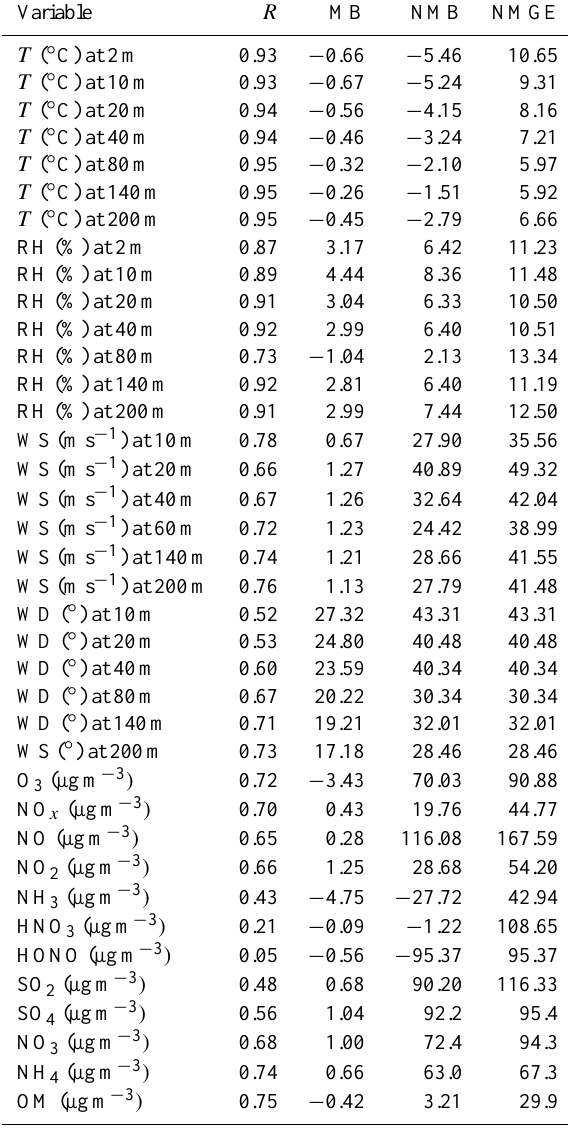
Table 2. Statistical indices of the comparison of WRF-Chem to ob- servations of temperature ( T ), relative humidity (RH), wind speed (WS), wind direction (WD), ozone (O 3 ) , nitrogen oxide (NO x ) , ni- tric dioxide (NO 2 ) , nitric oxide (NO), ammonia (NH 3 ) , nitric acid (HNO 3 ) , nitrous acid (HONO), sulfur dioxide (SO 2 ) , particle sul- fate (SO 4 ) , particle nitrate (NO 3 ) , particle (ammonium), and parti- cle OM, collected at Cabauw tower.